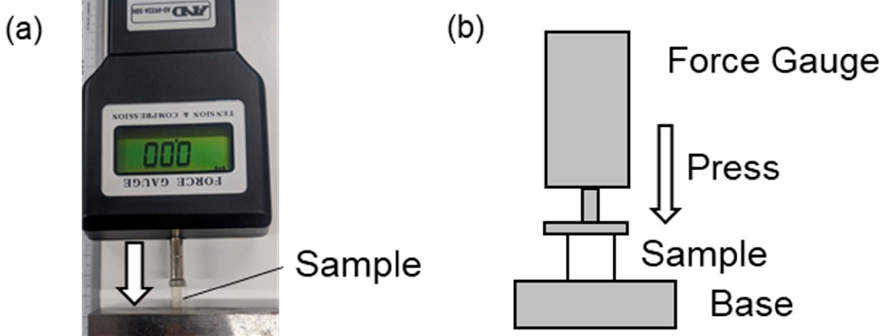
Figure 1. Experimental setup of simple push-in test to evaluate Young’s modulus: ( a ) actual setup and ( b ) configuration diagram.